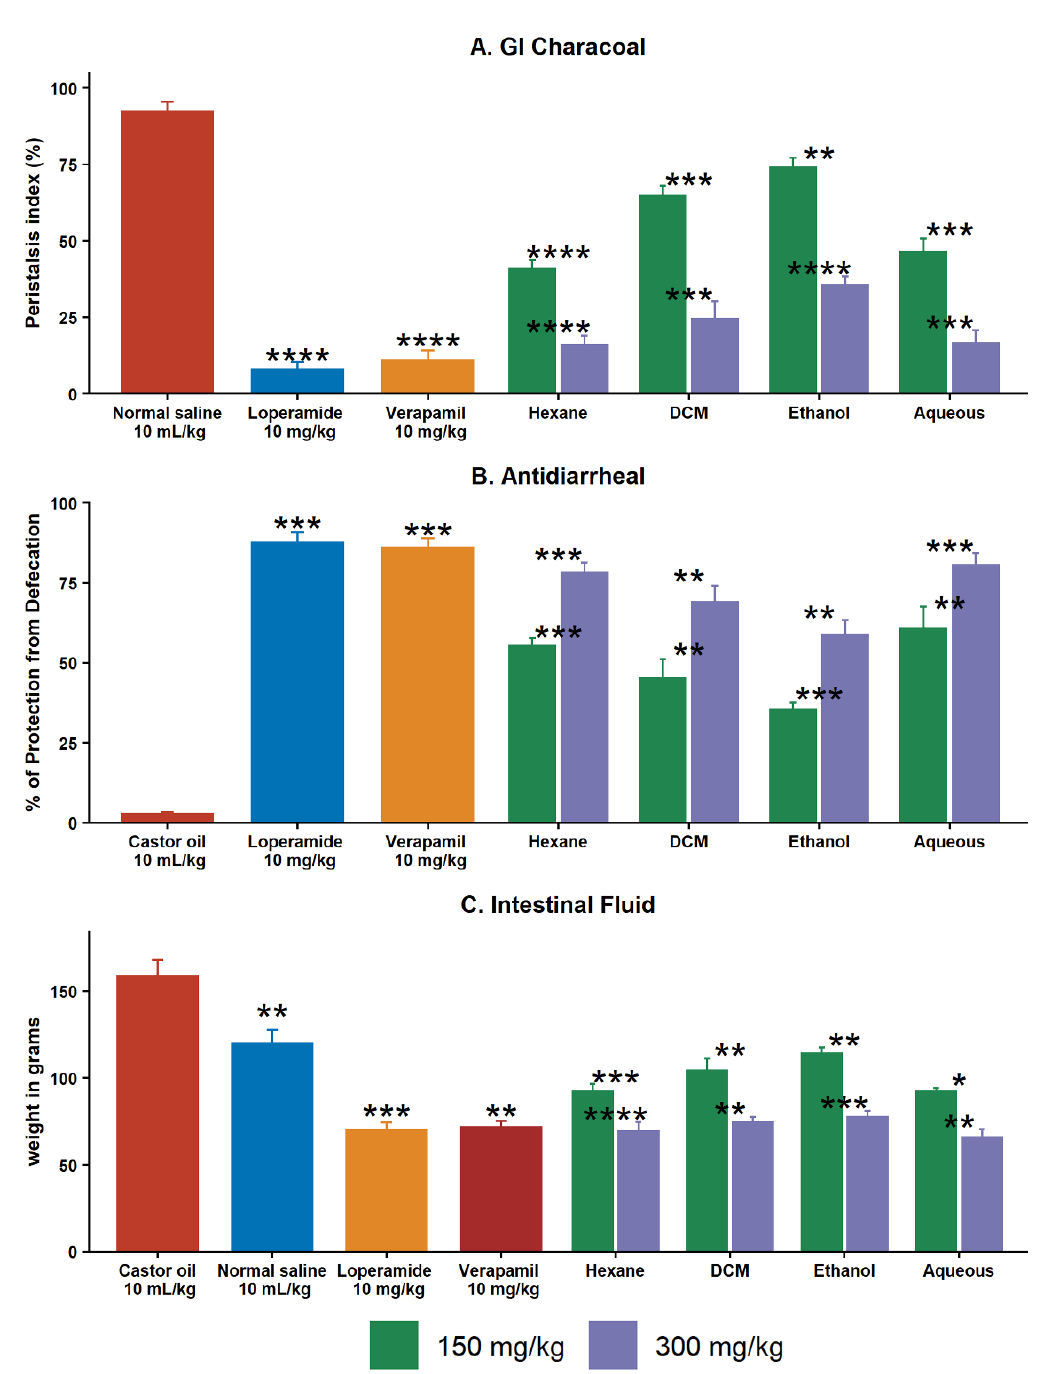
Figure 2. Gastrointestinal activities of in vivo activities of C. melo seed kernel sequential extracts. ( A ). Antiperistalsis, ( B ). antidiarrheal activity, and ( C ). GI fluid accumulation activity of verapamil, loperamide, and C. melo seed kernel sequential extracts. Data are expressed as the mean ± S.D. ( n = 4). A Student’s t–test (pairwise) was performed to determine significance when compared to control: p < 0.05 * p < 0.01, ** p < 0.001, *** p < 0.0001, **** p < 0.00001 were used to determine significance.